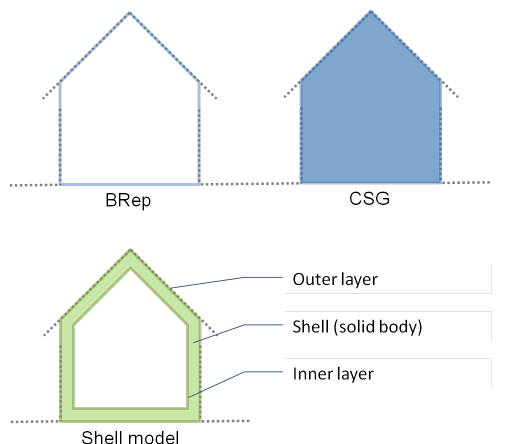
Figure 4. Comparison of the concepts of BRep (left), CSG (right), and shell models (bottom).